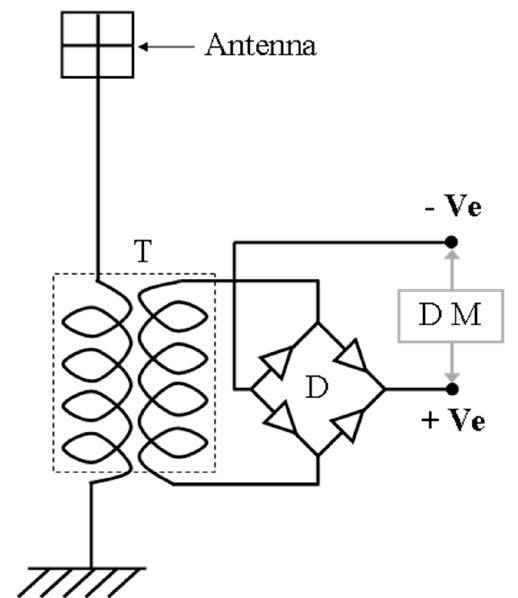
Figure 1. Schematic diagram of the electric power collector from the wind.